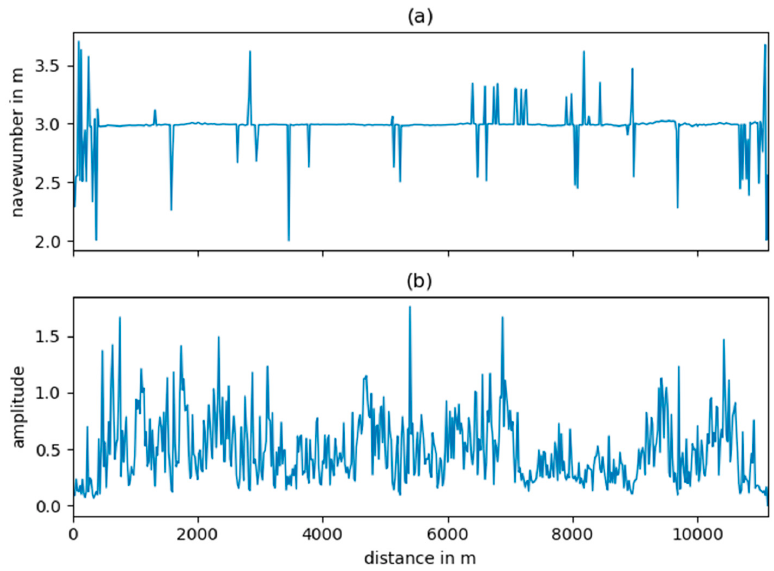
Figure 7. Cepstrum analysis of 40-m-long track segments; ( a ) position of cepstrum peaks at na- vewumbers between two and four meters and ( b ) corresponding peak